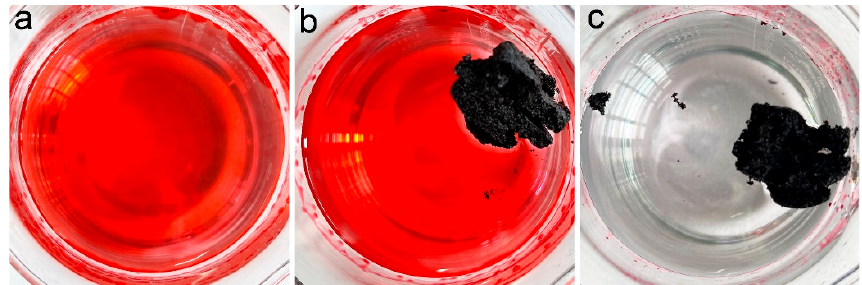
Figure 5. Removal of gasoline (dyed with Sudan red 5B) in simulated seawater by PCS. ( a ) gasoline in simulated seawater (dyed with Sudan red 5B) (0 min), ( b ) PCS starts to remove gasoline (dyed with Sudan red 5B) in simulated seawater (0 min), ( c ) PCS removes gasoline (dyed with Sudan red 5B) in simulated seawater for 2 min.